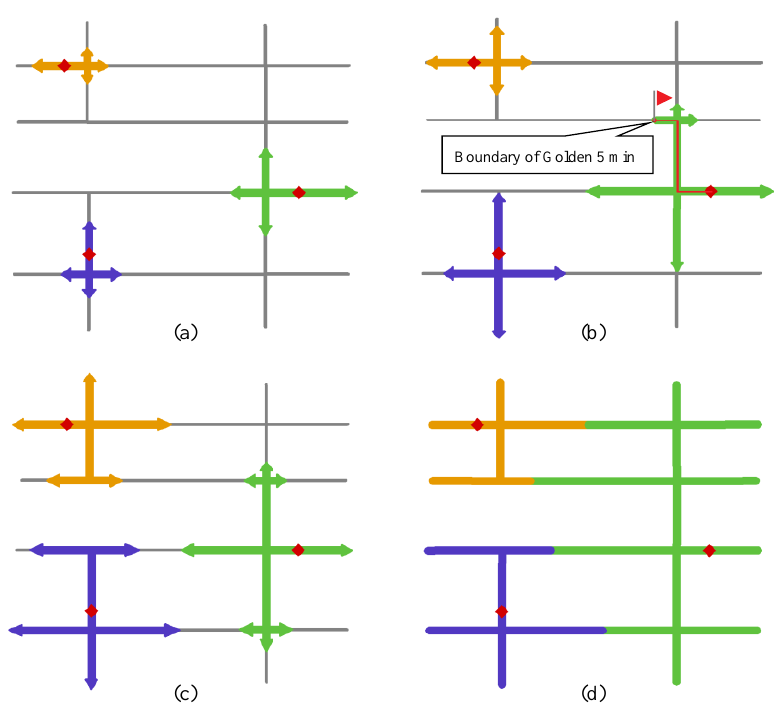
Figure 4. The implementing of the constrained Voronoi diagram: ( a ) expanding along the network simultaneously from the locations of fire stations, ( b ) stopping the operator that reaches the boundaries of Golden 5 min coverage and continuously expanding the others, ( c ) re-executing the operators synchronously when all of them reach the boundaries of Golden 5 min coverage, and ( d ) obtaining the final result.